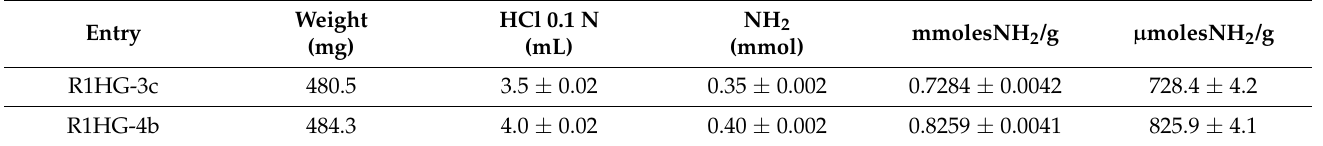
Table 6. Content of NH 2 of R1HG-3c and R1HG-4b by potentiometric titration of an exactly weighted amount of